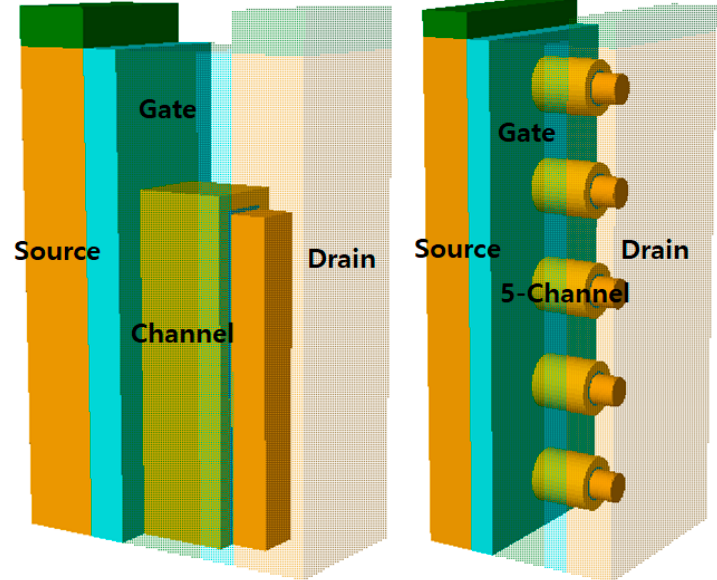
Figure 1. 3D technology computer-aided design (TCAD) structure of the FinFET and 5ch-nanowire FET (NW). ( Left ) FinFET, ( Right ) 5ch-NW. The 5ch-NW was stacked in five stages to match the FinFET’s current level and device size.